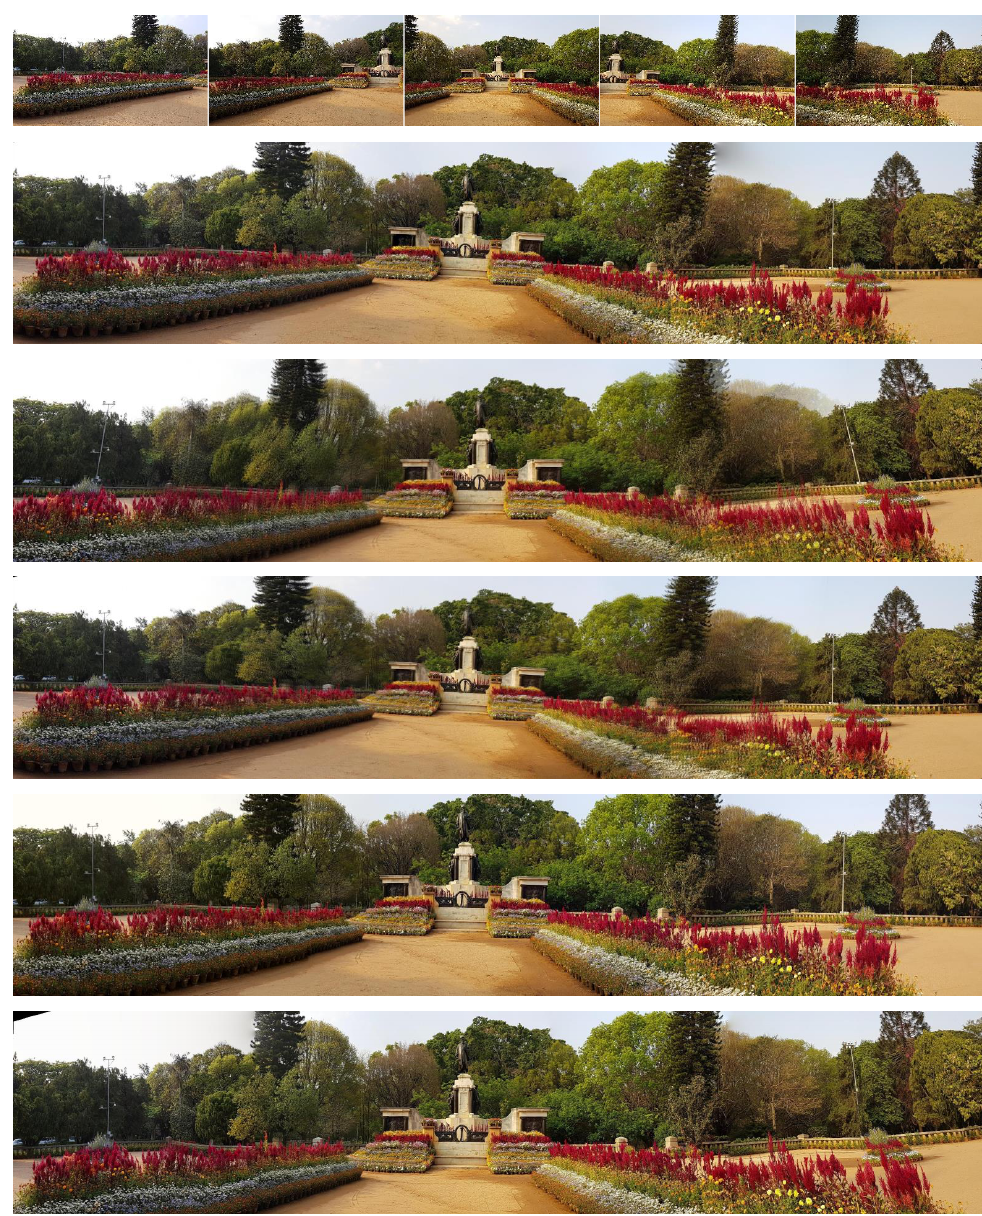
Figure 1. Sample constituent (top row) and stitched images from set #1 of ISIQA database with various types of